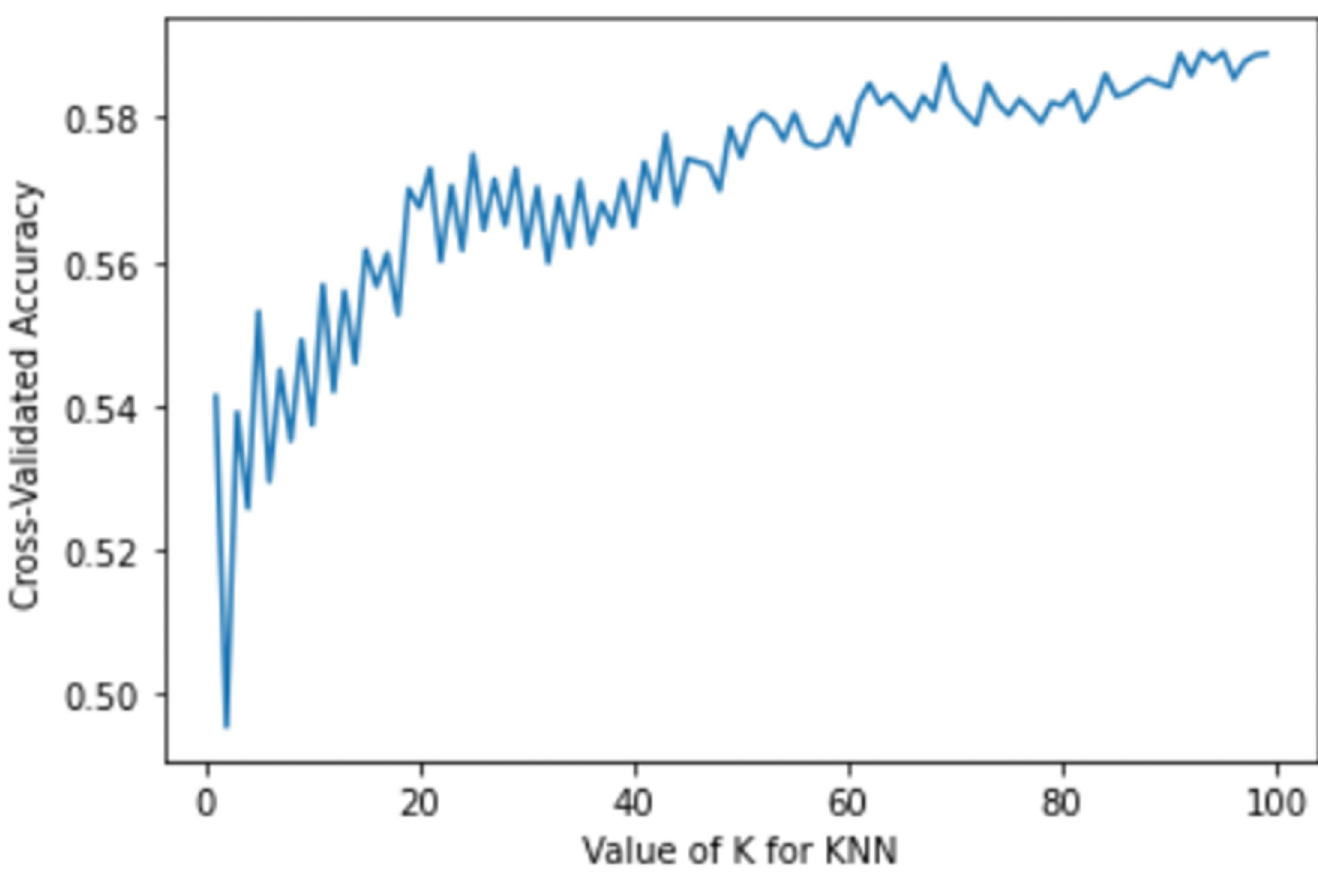
Fig 1. Hyperparameter tuning in